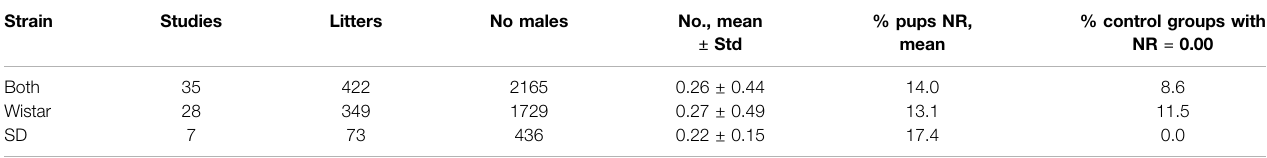
TABLE 4 | Control values for nipple retention (NR).